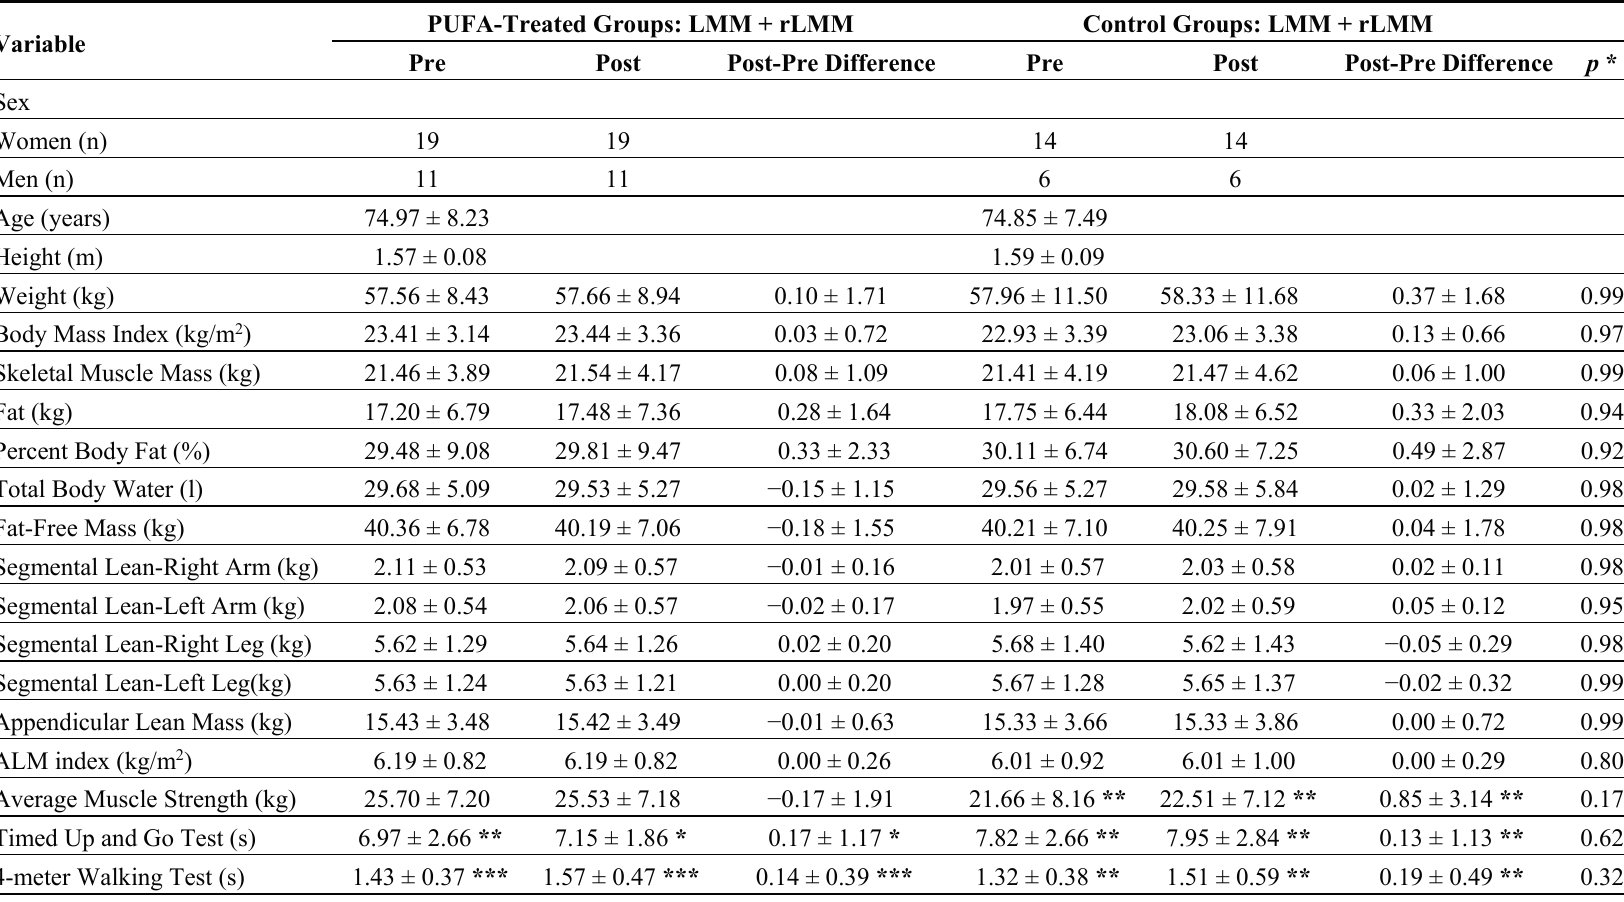
Table 4. Body composition, muscle strength and physical performance before and after 12-week intervention period in all studied subjects (with low muscle mass—LMM and risk of low muscle